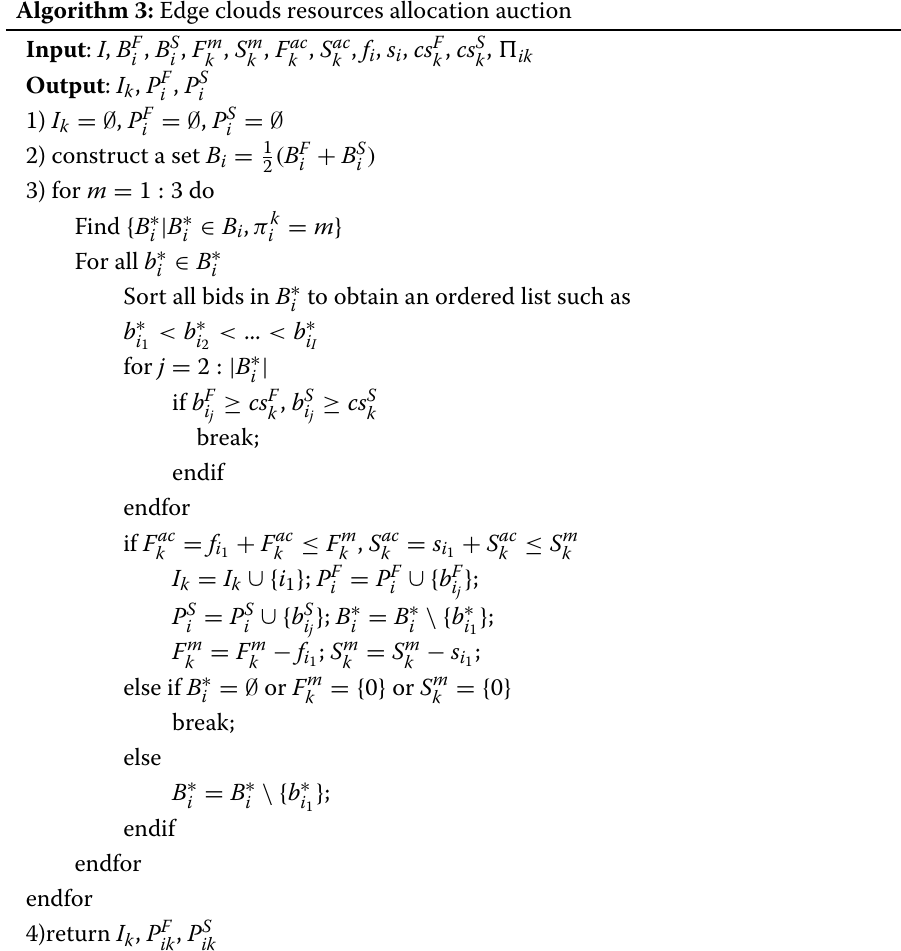
Algorithm 3: Edge clouds resources allocation